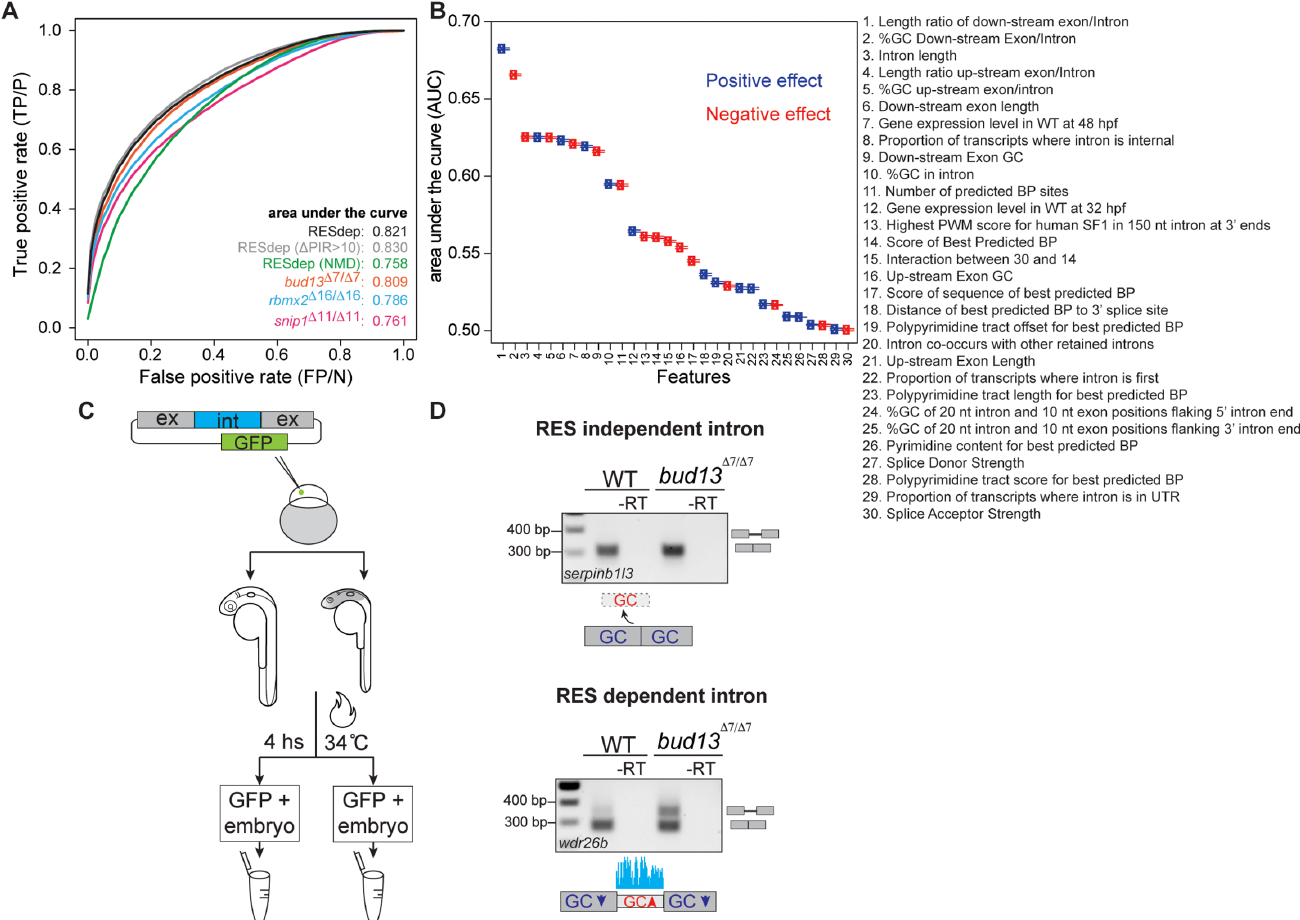
Fig 6. Logistic regression model can accurately classify RES-dependent and non-dependent introns. (A) Classification performance of logistic regression models for different data sets of differentially retained vs. Ctr introns. ROC curves are averaged over 10,000 repeated holdout experiments where models have been trained with randomly sampled subsets of 90% (1,268) of the RESdep introns versus 1,268 Ctr introns with 30 features (S3 Table) and Lasso feature selection. Classification performance was estimated using the remaining 10% (141) RESdep introns and 141 randomly sampled Ctr introns. Having held fixed parameters, the same model was used to estimate classification performance with randomly sampled 141 introns from the other RES-dependent data sets, namely: (i) “RESdep ( Δ PIR > 10)” introns from the “RESdep” set with Δ PIR > 10 in all three mutants (871 introns); (ii) “RESdep (NMD)”, introns from the “RESdep” set predicted to trigger NMD when retained (574 introns); (iii) “ bud13 Δ 7/ Δ 7 ”, introns with Δ PIR > 15upon bud13 mutation at 32 hpf (2,363 introns); (iv) “ rbmx2 Δ 16/ Δ 16 ”, introns with Δ PIR > 15 upon rbmx2 mutation at 48 hpf (2,186 introns); and (v) “ snip1 Δ 11/ Δ 11 ”, introns with Δ PIR > 15upon snip1 mutation at 48 hpf (2,675 introns). 95% confidence interval of reported average AUCs corresponds to AUC ± 0.001. (B) Capacity of each feature to discriminate between “RESdep” and “Ctr” introns, measured as AUC (average area under ROC curve) when used as the only feature in a one-feature logistic regression model. (C) Schematic of the experiment performed to validate the predicted features, see Material and Methods for details. (D) RES dependent but not RES independent intron was retained in bud13 Δ 7/ Δ 7 mutant as the regression model predicted. The validation experiment was done using two independent biological replicates (see S12A